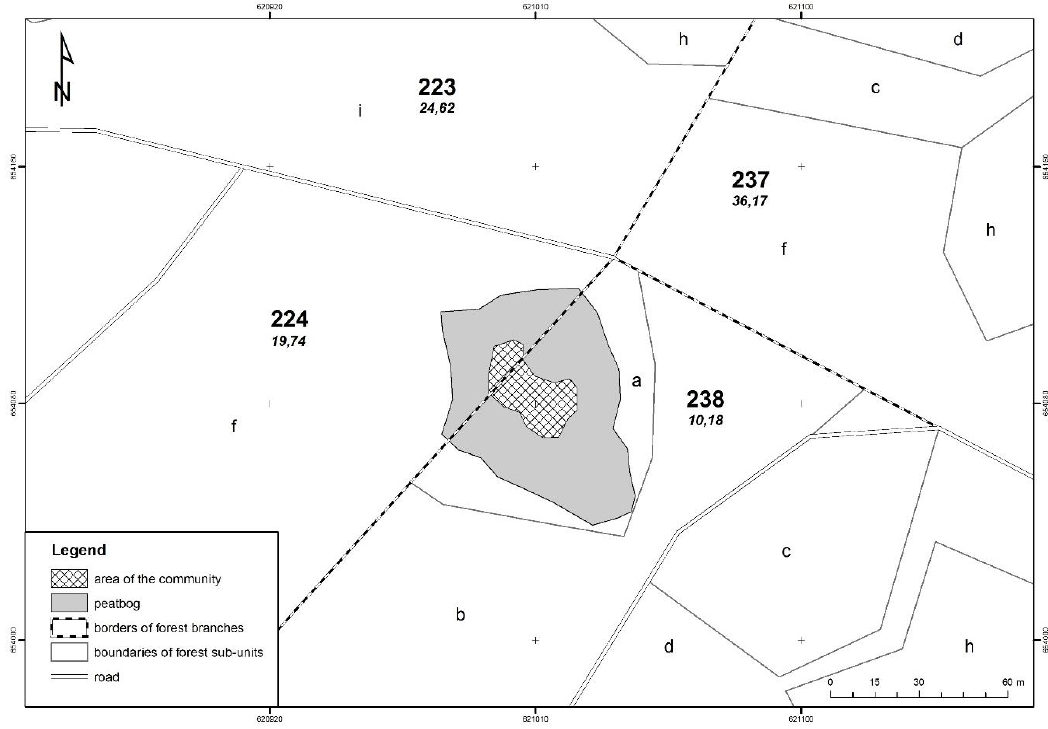
Figure 2. The range of plant community with Chamaedaphne calyculata at the new site near Nerwik village .